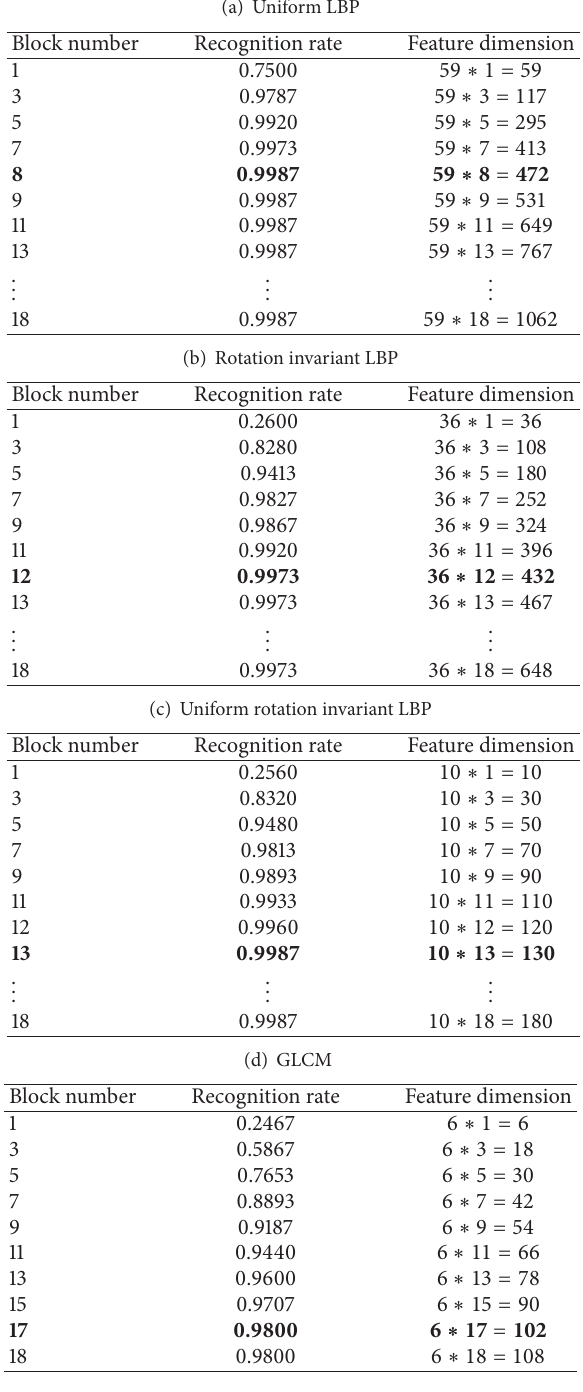
Table 3: Block selection using the estimate of the amount of information in each block.